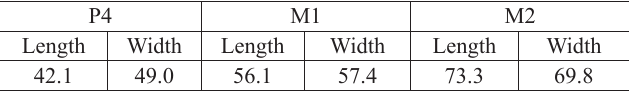
Table 1. Measurements (in mm) of upper dentition of SYSU-M-4, the holotype of Maobrontops paganus gen. et sp. nov. P4 M1